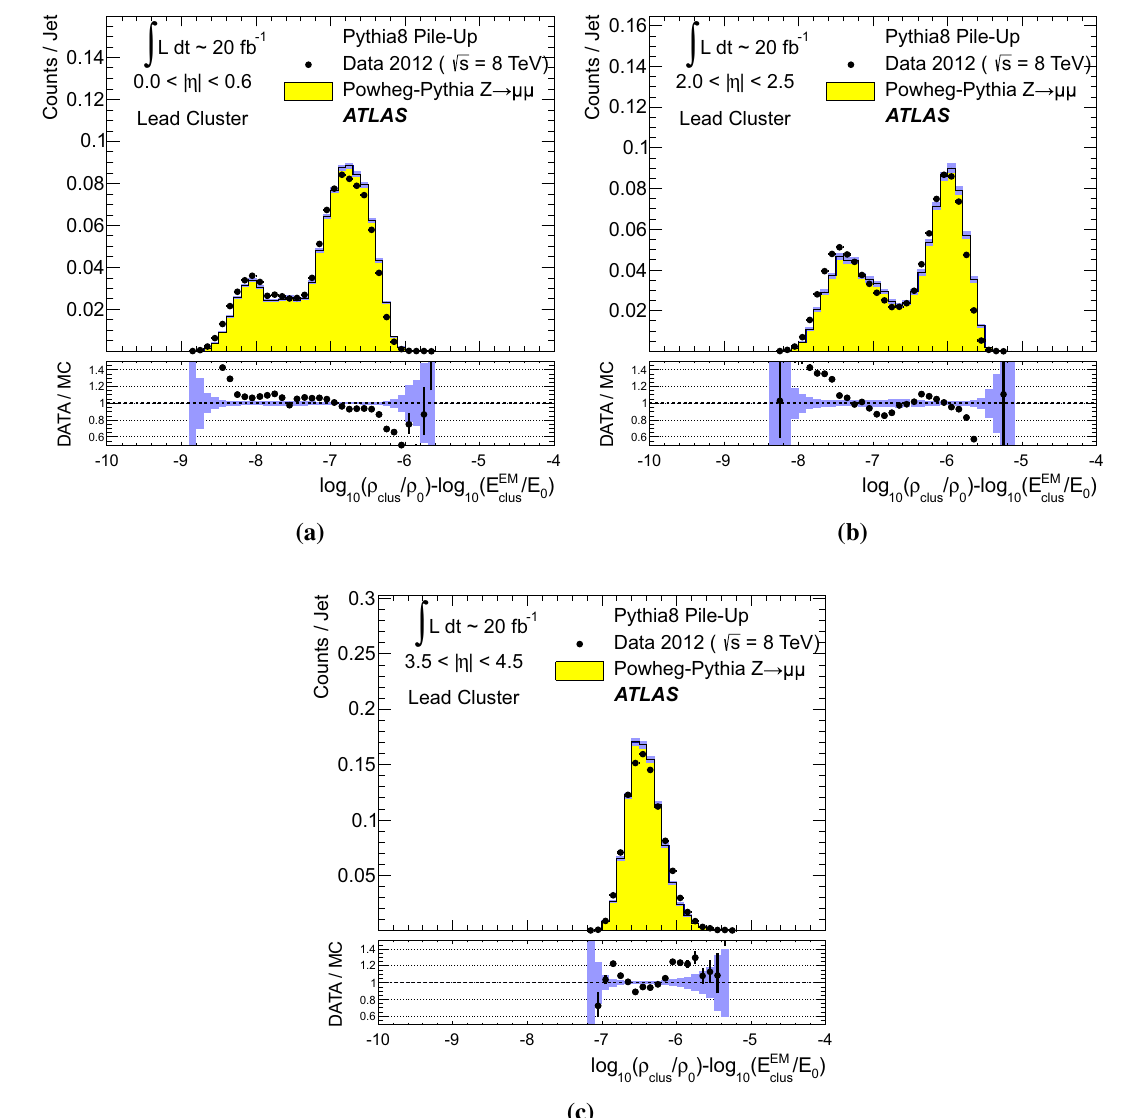
Fig. 37 Thedistributionoftheleadingtopo-clustersignaldensitymea- simulated pile-up for Z → μμ events recorded in 2012. The ratio of the / E ) in fully calibrated jets recon- distribution from data to the one from MC simulations is shown below sure log 10 (ρ clus /ρ 0 ) − log 10 ( E EM 0 clus each plot. The shaded bands show statistical uncertainties for the distri- structed with the anti- k t algorithm with R = 0 . 4 and 30GeV < < 40GeV in regions of a the central ( | η | < 0 . 6), b the p LCW + JES butions from MC simulations and the corresponding uncertainty bands jet T , jet in the ratio plots. The reference scale for ρ clus is ρ 0 = 1MeV / mm 3 , end-cap (2 . 0 < | η jet | < 2 . 5), and c the forward (3 . 5 < | η jet | < 4 . 5) calorimeters in ATLAS. Data is compared to MC simulations with fully and for the energy E 0 =